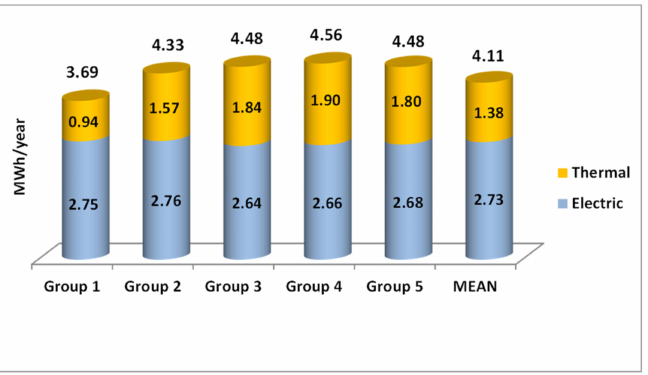
Figure 6. Thermal, electric, and total mean energy consumption per inhabitant of each group of